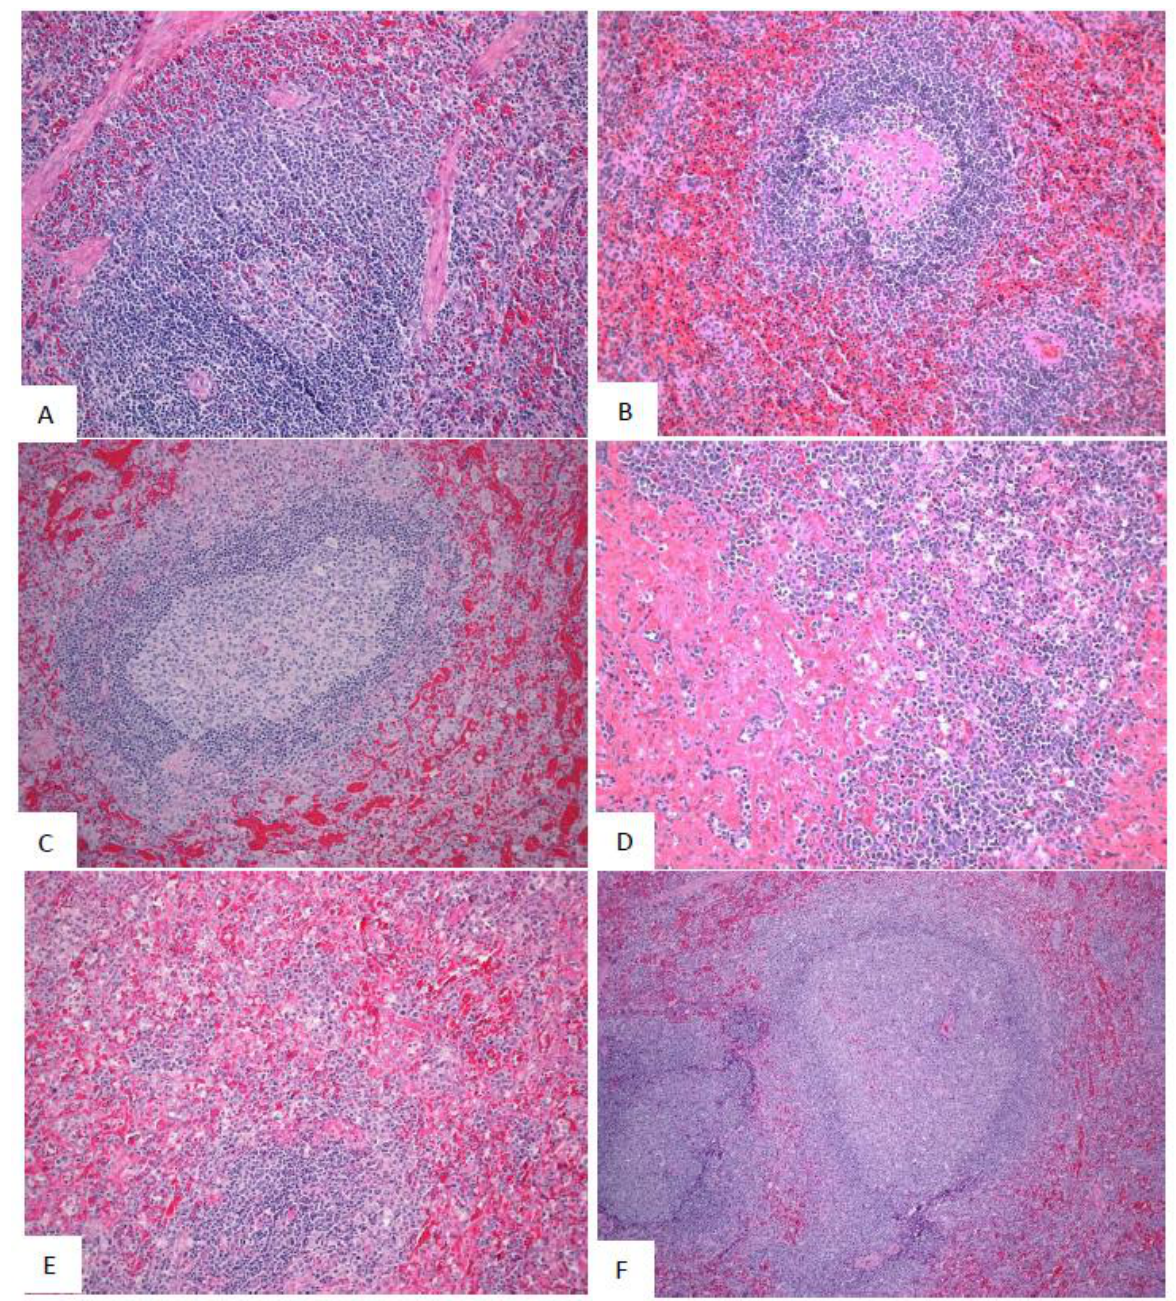
Figure 9. Representative images of microscopic findings: Spleen. Microscopic findings at necropsy in cynomolgus macaques intramuscularly exposed to SUDV Gulu. Spleen. ( A ) Day 21 control, No. 478. Essentially normal tissue. 4x; ( B ) Day 2 PE scheduled necropsy, No. 491. Follicles contain increased hyaline material, consistent with spontaneous change. 20x. ( C ) Day 5 PE scheduled euthanasia, No. 493. There is moderate lymphoid depletion with deposition of fibrin within the perifollicular marginal sinus. 20x; ( D ) Day 7 PE scheduled necropsy, No. 477. There is moderate lymphoid depletion with diffuse fibrin deposition. 20x; ( E ) Day 9 PE scheduled necropsy, No. 476. There is lymphoid depletion with lymphocytolysis and marginal sinus fibrin deposition that extends into the red pulp. 20x; ( F ) Day 21 PE SUDV-exposed survivor, No. 487. Follicles are enlarged with prominent germinal centers (follicular hyperplasia). 10x.